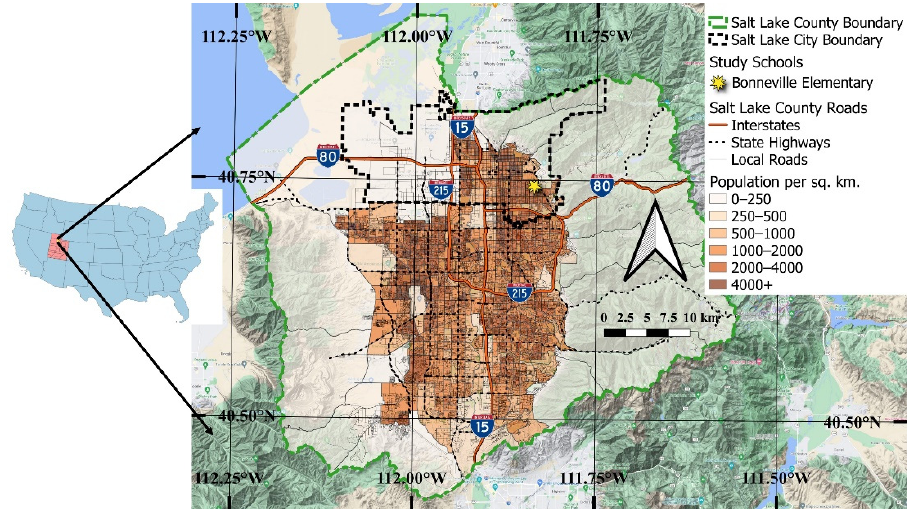
Figure 1. Salt Lake City and Salt Lake County within Utah and the United States (left inset) with the study school and interstate highways (I-15, I-80, I-215) noted.